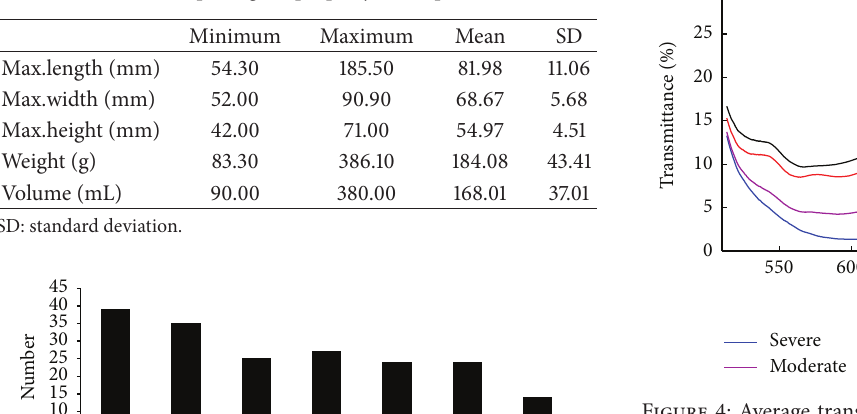
Table 1: Morphological property of the potatoes.